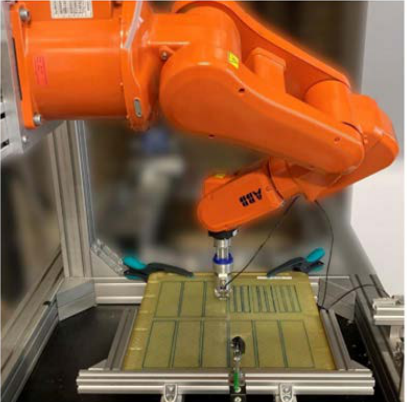
Figure 23. Experimental setup for birefringence measurements and applications.